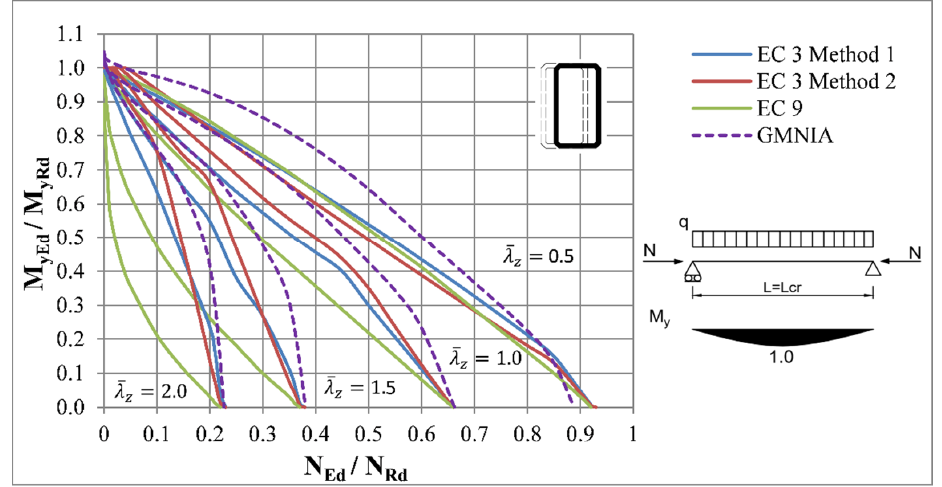
Figure 39. Interaction curves for beam-columns with RHS cross-section without lateral restraints.